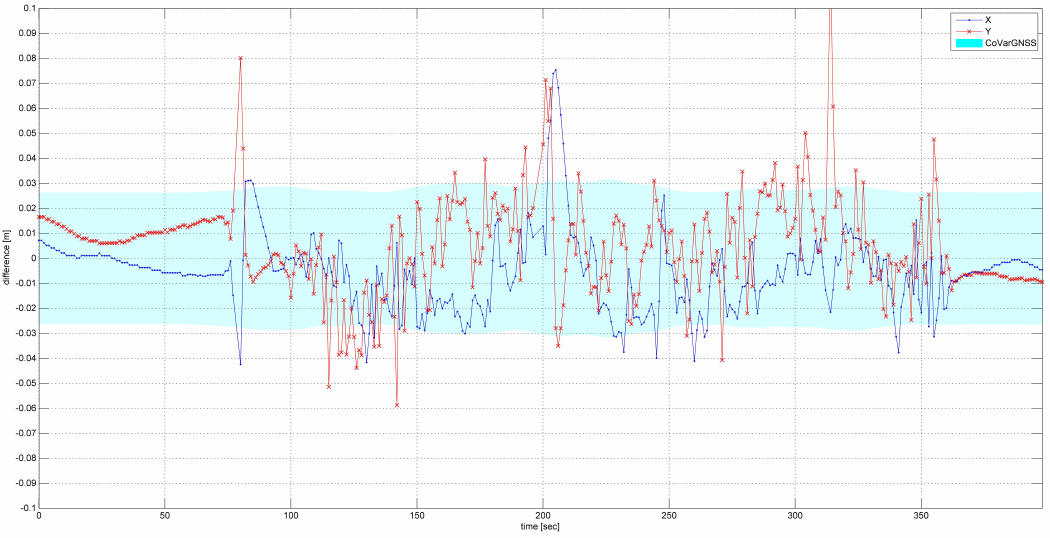
Figure 7. Differences between the Kalman filter solution with the IMU and total station and the solution with GPS and IMU. The variations in the east and north are presented in red and blue, respectively. The temporal resolution is one second. The cyan area represents the GPS variance (95%) calculated by the Novatel Inertial